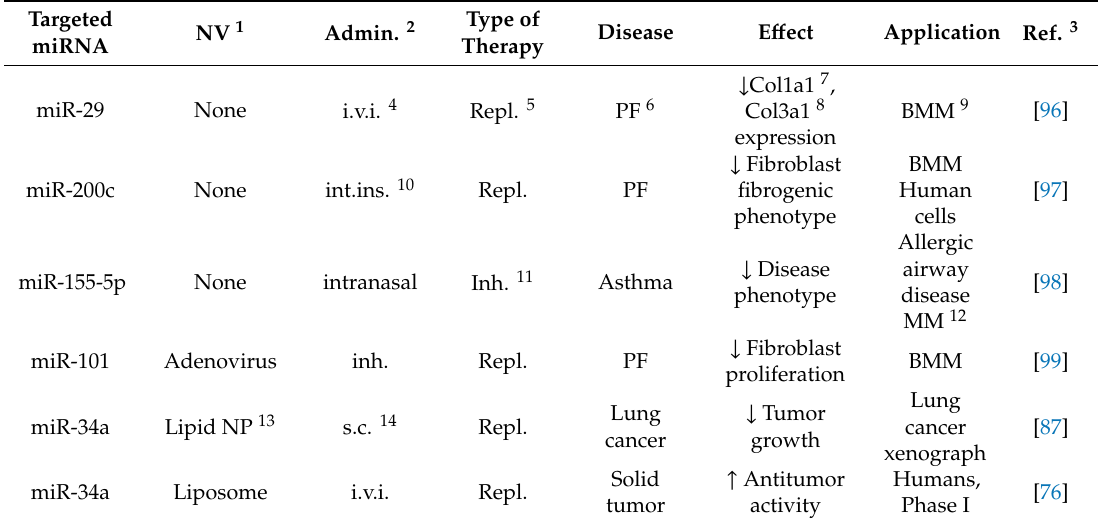
Table 1. Examples of miRNA-based therapies applied in lung